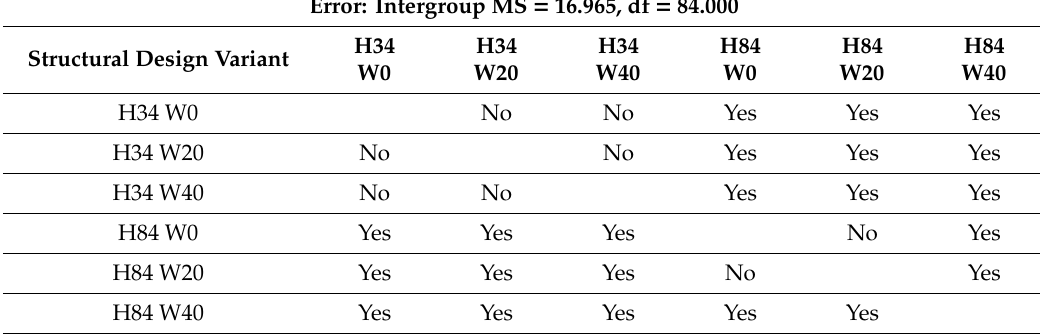
Table 2. Analysis of variance for means: a comparison of the e ff ect of reactor structural design on oxygenation capacity OC. “Yes”—statistically significant e ff ect; “No”—statistically non-significant e ff ect; MS—mean square; df—degrees of